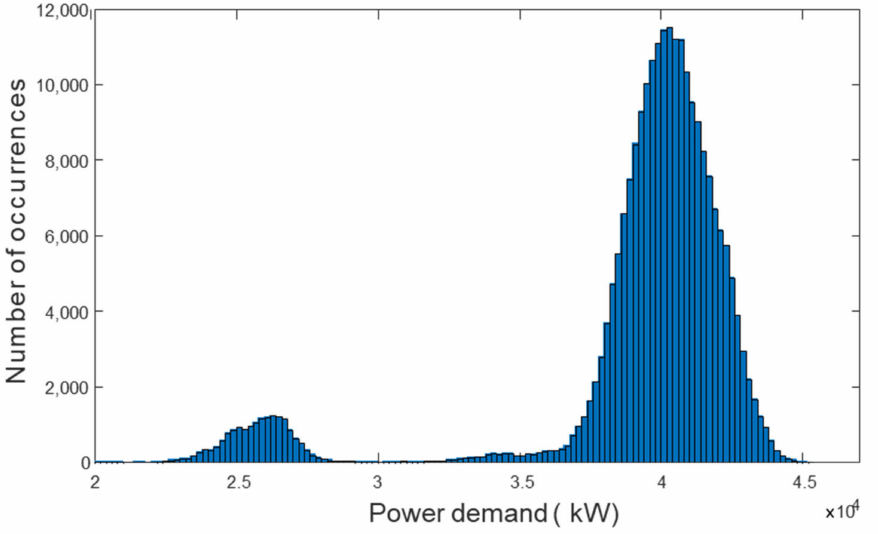
Figure 5. Number of point occurrences in power demand data from March to June